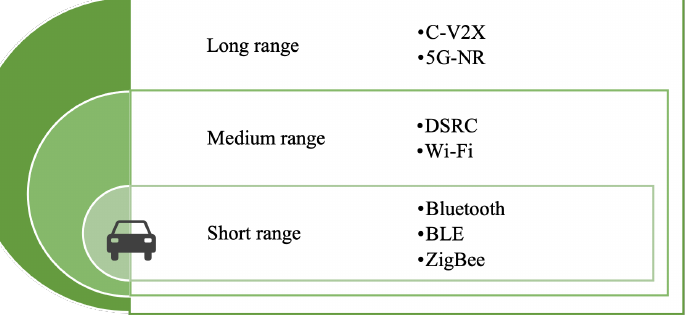
Figure 5. Taxonomy of IoV communication technologies with communication